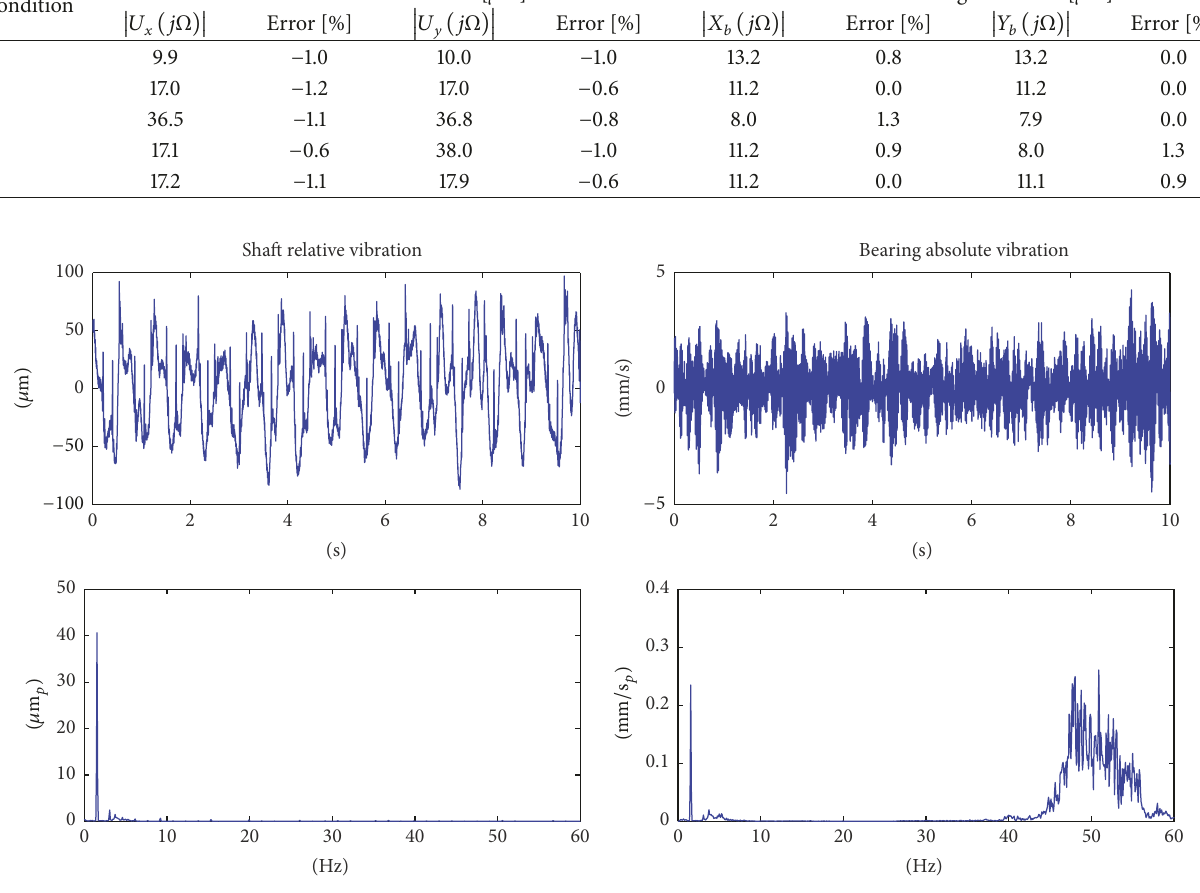
Figure 6: Shaft relative and bearing absolute vibrations at X -direction of the upper journal bearing when generator rotor had unbalance G4.25 at the relative time t 1 +